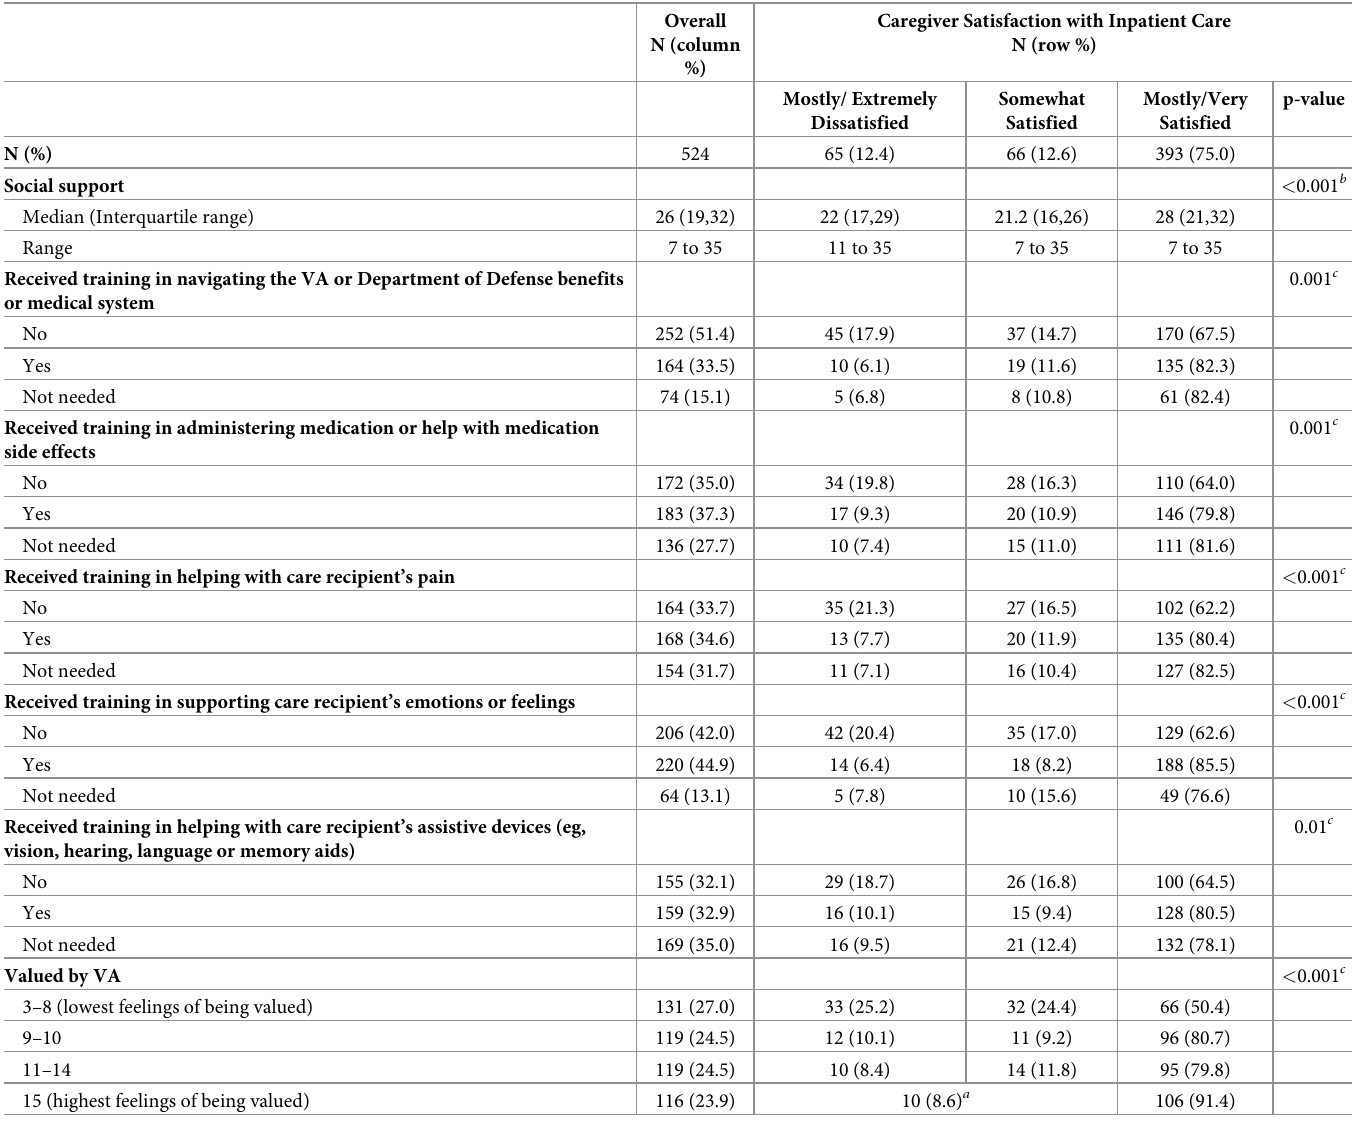
Table 2. Addressable factors versus caregiver satisfaction with inpatient